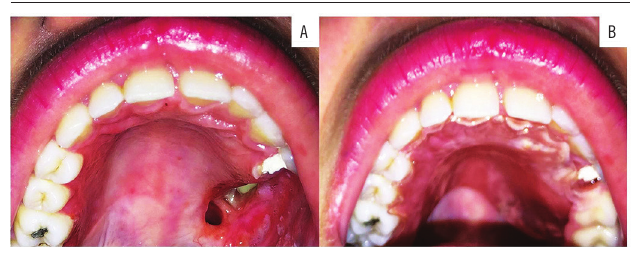
figurE 6 − The patient is under clinical and radiographic follow-up and has been disease free for two years